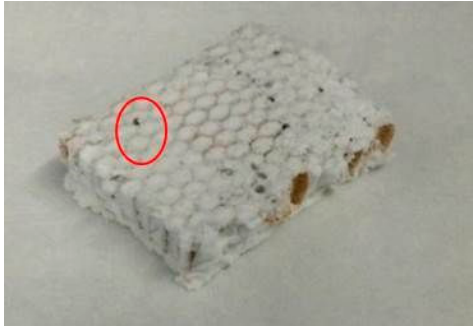
Figure 7. Super-flexible silica aerogel (SA1) with aramid honeycombs C1-3.2-29.